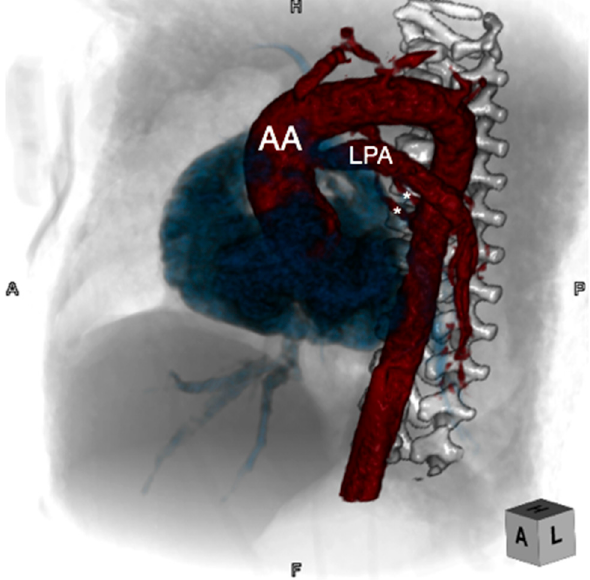
Figure 9. Computed tomographic three-dimensional (3D) reconstruction angulated in a left anterior oblique plane demonstrating an anomalous left pulmonary artery (LPA) arising from the ascending aorta (AA) in a patient with tetralogy of Fallot. Two small major aortopulmonary collateral arteries (asterisks) are demonstrating arising from the proximal thoracic descending aorta and coursing to the right lung.